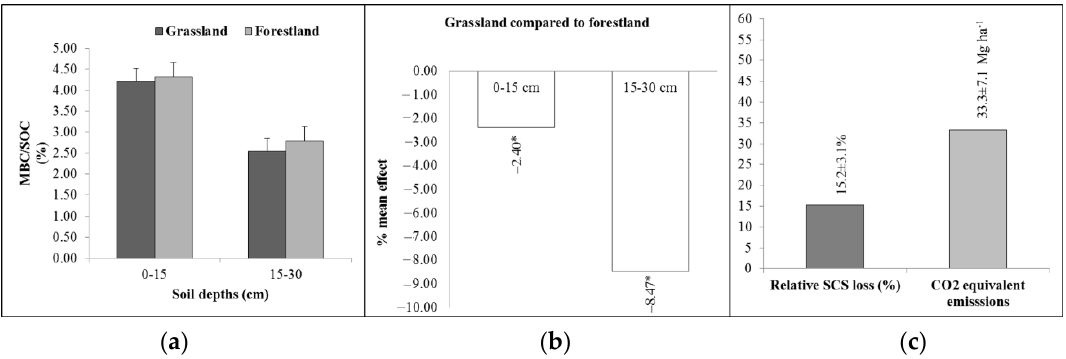
Figure 4. Effects of grassland compared to native forestland on ( a ). Microbial biomass carbon (MBC)/ soil organic carbon (SOC) (%), ( b ). Percent mean effect on MBC/SOC (%), and ( c ). Relative soil carbon stock (SCS) loss and carbon dioxide (CO 2 ) equivalent emissions (Note: Metadata has been represented as mean ± S.E.).